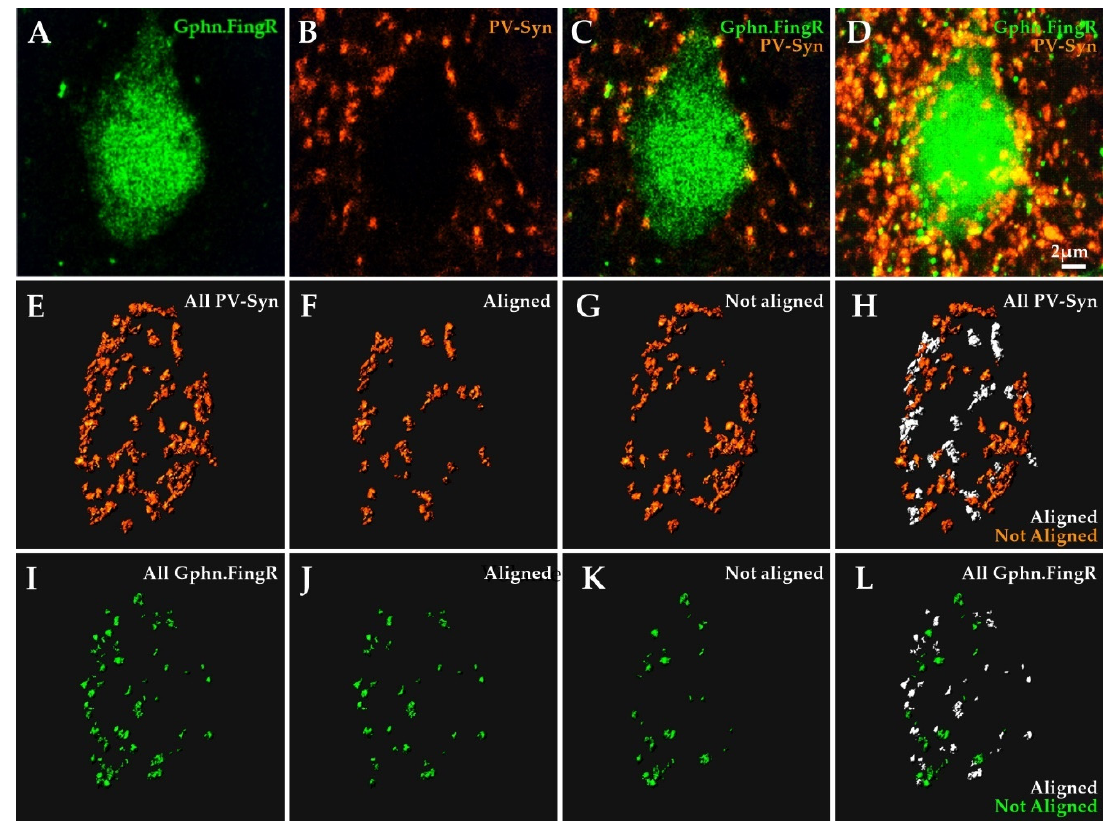
Figure 5. Object-based image analysis approach for quantitative assessment of Gephyrin.FingR and PV bouton alignment; ( A – C ) optical section of a Gephyrin.FingR (green) labeled L2/3 Pyr neuron soma and surrounding PV-Syn bouton fluores- cence (orange); ( D) maximum intensity projection of the same cell; ( E ) 3D rendering of all soma-adjacent PV-Syn boutons; ( F ) subset of boutons in E that aligned with Gephyrin.FingR ( ≤ 0.15 µm apart, edge-to-edge); ( G ) subset of boutons in E that did not align with Gephyrin.FingR (>0.15 µm apart); ( H ) all PV boutons color-coded based on their alignment with postsynaptic Gephyrin.FingR; ( I ) 3D rendering of all somatic Gephyrin.FingR; ( J ) subset of Gephyrin.FingR in I that could be aligned with PV boutons; ( K ) subset of Gephyrin.FingR puncta in I that did not align with PV boutons; ( L ) all Gephyrin.FingR puncta color-coded based on their alignment with presynaptic PV boutons.